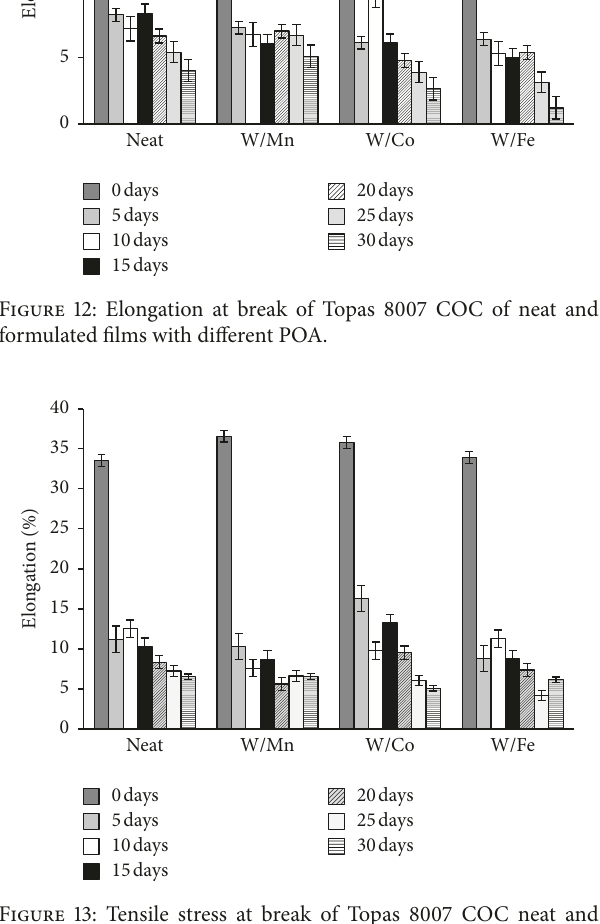
Figure 13: Tensile stress at break of Topas 8007 COC neat and formulated films with different